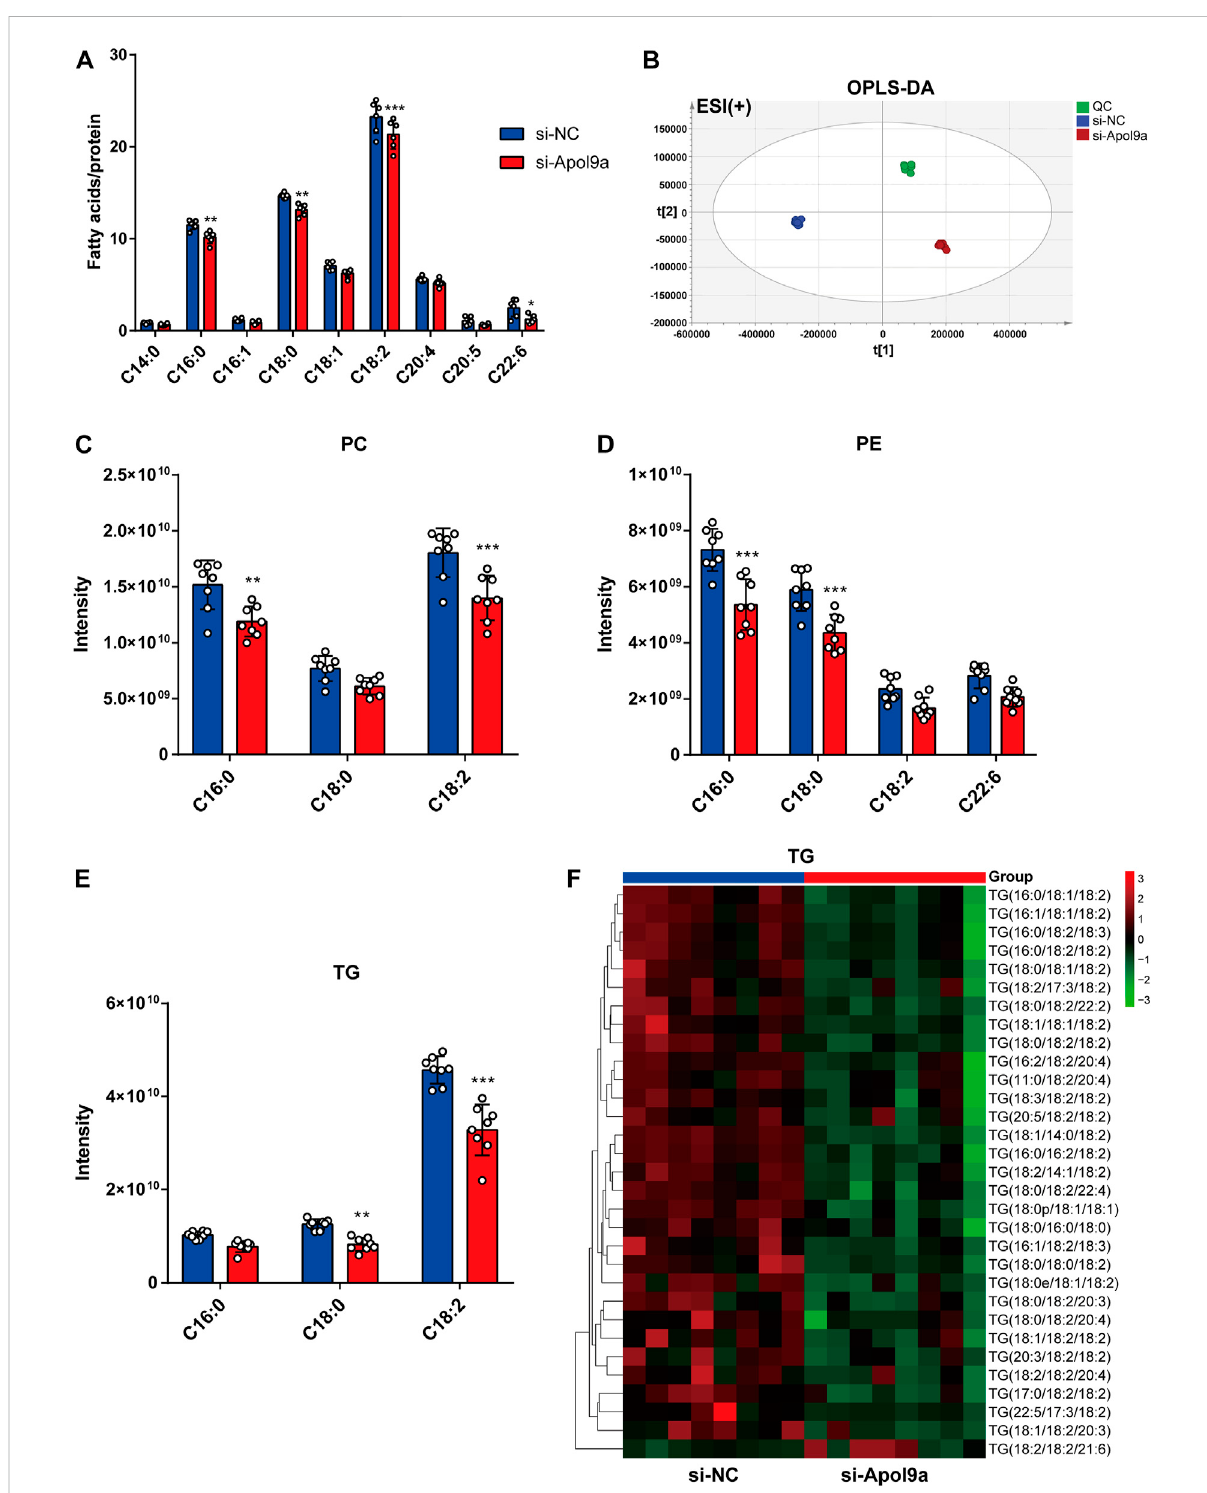
FIGURE 5 Fattyacidmethylesteranalysisandlipidomicanalysis.Aftermyogenicdifferentiationfor4 days,C2C12cellstransfectedwithsi-NCorsi- Apol9a werecollected, and cellular fatty acid and lipidomic analyses were performed. (A) Cellular fatty acid pro fi les were detected through GC-MS following C2C12 differentiation. (B) orthogonalpartialleastsquaresdiscriminantanalysis(OPLS-DA)oflipidpro fi lesinpositiveionmodesfromC2C12cellswithorwithout Apol9a knockdown. (C) The compositionofphosphatidylcholine(PC)(C16:0,C18:0,C18:2)amongalllipids. (D) Thecompositionofphosphatidylethanolamine(PE)(C16:0,C18:0,C18:2, C22:6)amongalllipids. (E) Thecompositionoftriacylglycerol(TG)(C16:0,C18:0,C18:2)amongalllipids. (F) Heatmapshowingthedifferentiallipidcompositionof TGs (C18:0, C18:2). The data are presented as mean ± SEM ( n = 8, each group). * p < 0.05, ** p < 0.01, *** p < 0.001 vs. si-NC